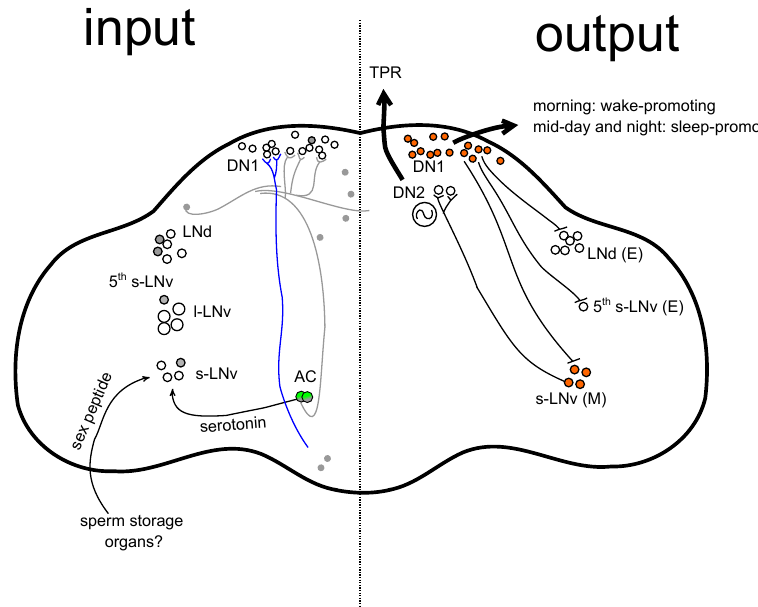
Figure 2. TRPA1 and clock circuits in the Drosophila brain that regulate rhythmic behaviours. The left hemisphere shows sensory input pathways to the brain. Right hemisphere shows processing and output that controls rhythmic behaviours. Clock neurons and Anterior Cell (AC) neurons are labelled. Green, TRPA1 expression in AC neurons [19]; grey, trpA1 SH -gal4 expression potentially in some clock neurons and in trpA1 SH -gal4 + cell bodies that are not clock neurons [23]; blue, ppk-gal4 expression [24]; trpA1 SH -gal4 + and ppk-gal4 + neurons contact DN1 clock neurons [24]; small arrows, input (via neurotransmitter or neuropeptide) to small lateral ventral neurons (s-LNv) [25,26]; oscillation, the number of s-LNv/DN2 contacts fluctuates throughout the day to regulate temperature preference rhythm (TPR) [26]; bar-headed arrows, DN1 inhibit morning (M) and evening (E) clock cells to regulate siesta sleep [27]; orange, a functional circadian clock in the DN1 or s-LNv is sufficient for siesta during warm temperatures